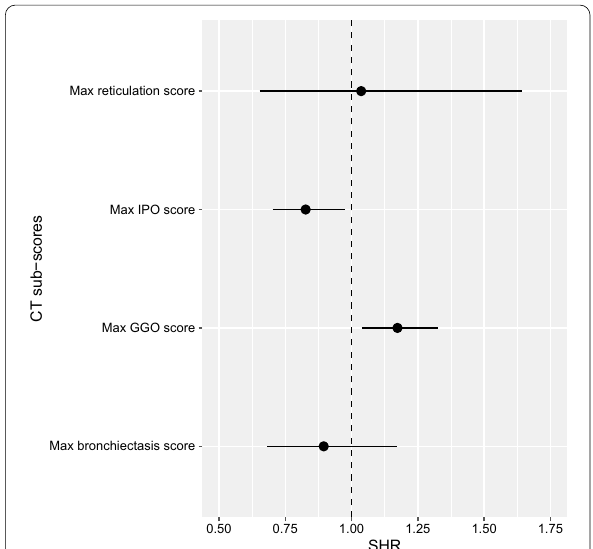
Fig. 4 Fine and grey competitive risk regression of CT derived‑scores to predict SARS‑CoV‑2 negativation on RT‑PCR. The plot presents SHR estimates of CT‑derived sub‑scores to predict SARS‑CoV‑2 negativation on RT‑PCR. Closed circles are SHR estimates and bars are their 95% confidence interval. Broken lines represent SHR equal to one. CT computed tomography, GGO ground glass opacification, IPO intense parenchymal opacification, SHR subdistribution hazard ratio, RT-PCR real‑time reverse transcriptase polymerase chain